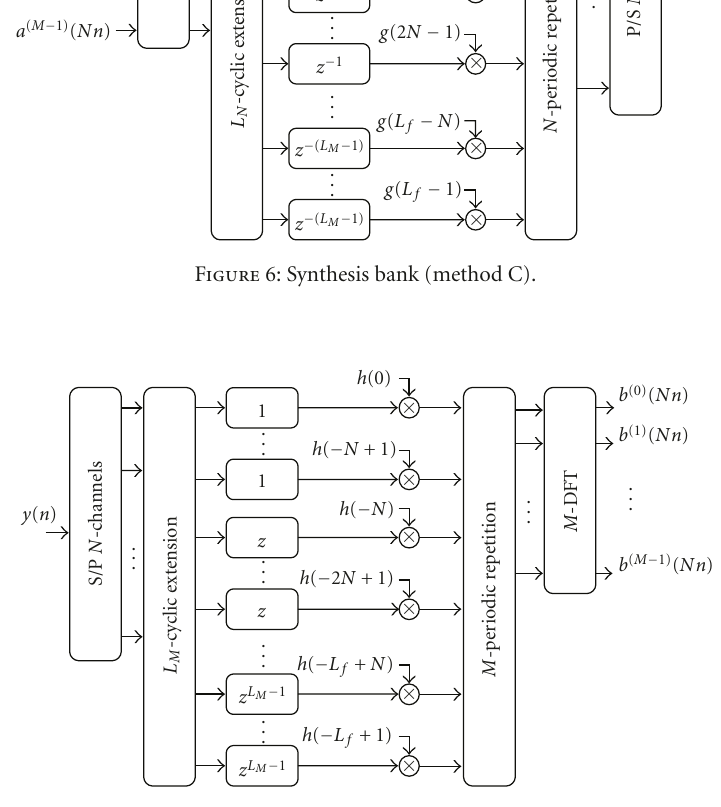
Figure 7: Analysis bank (method